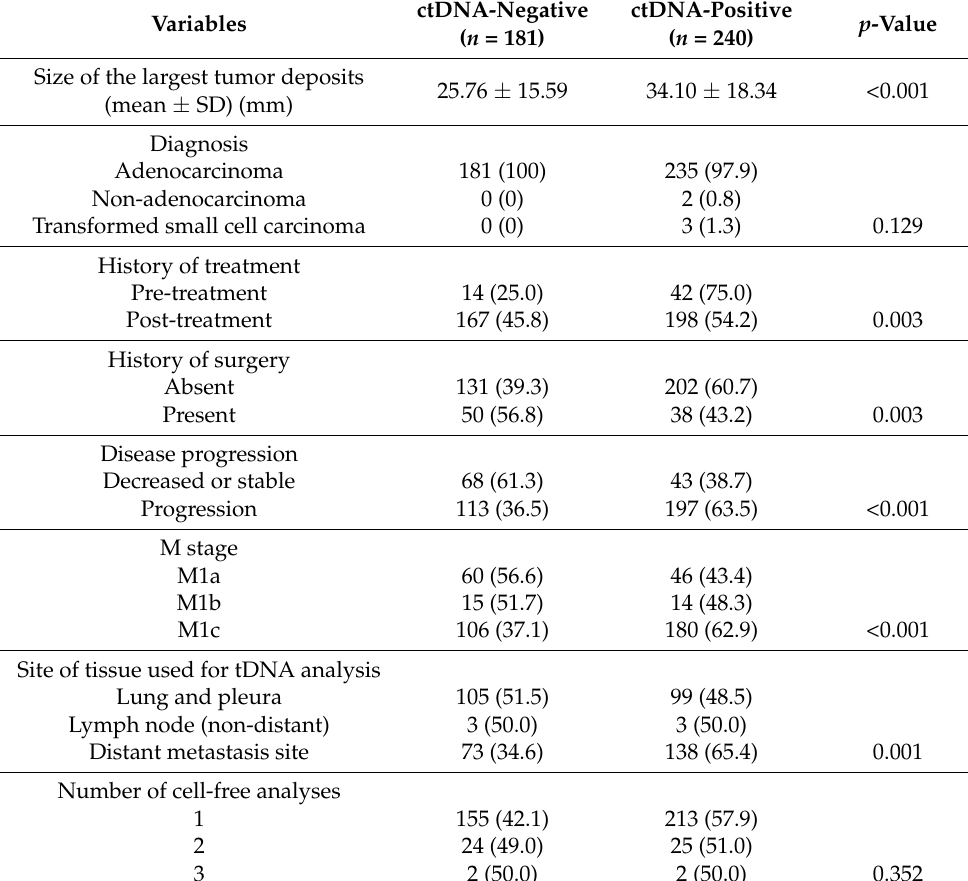
Table 3. Comparison of clinicopathological parameters between ctDNA-positive and